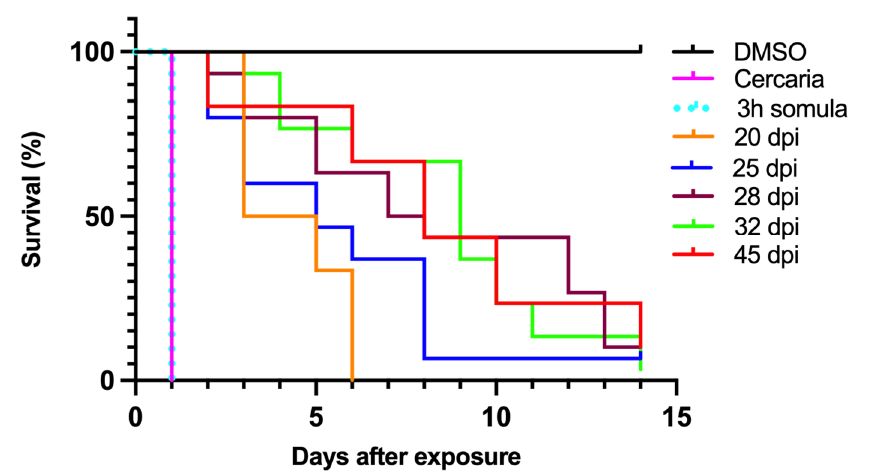
Figure 6. OXA treatment of life stages of S. mansoni.